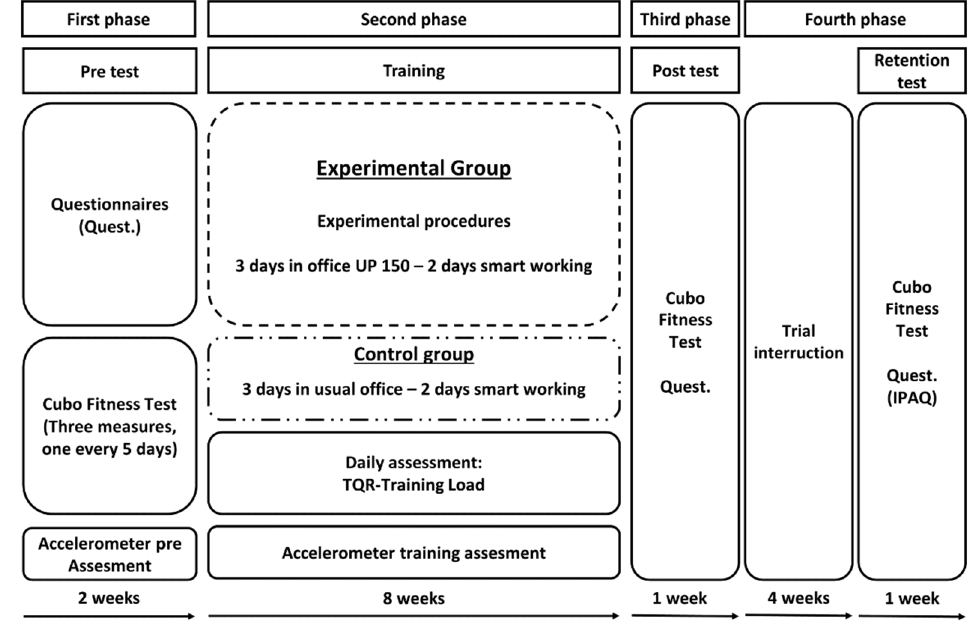
Figure 1. Protocol of the study.